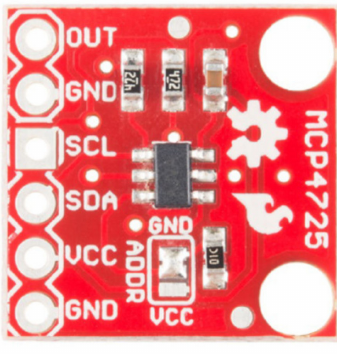
Figure 2. INA219. Source: [34].